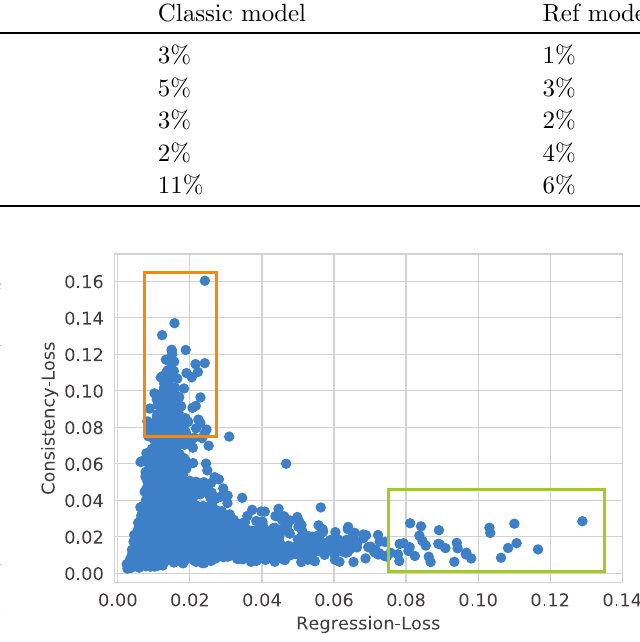
Fig. 7. Comparison of consistency and regression loss values of the classic model prediction on the synthetic